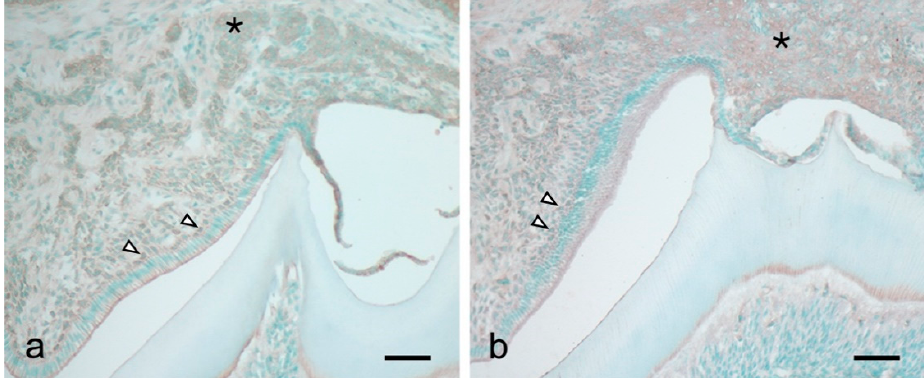
Figure 3. Immunohistochemical detection of KC ( a ) and MIP-2 ( b ) in the tooth organ at 14 dPN. Both chemokines were expressed in the papillary layer (arrowheads) and adjacent odontogenic epithelial cells over the tooth organs (asterisk). Bars = 50 μ m.